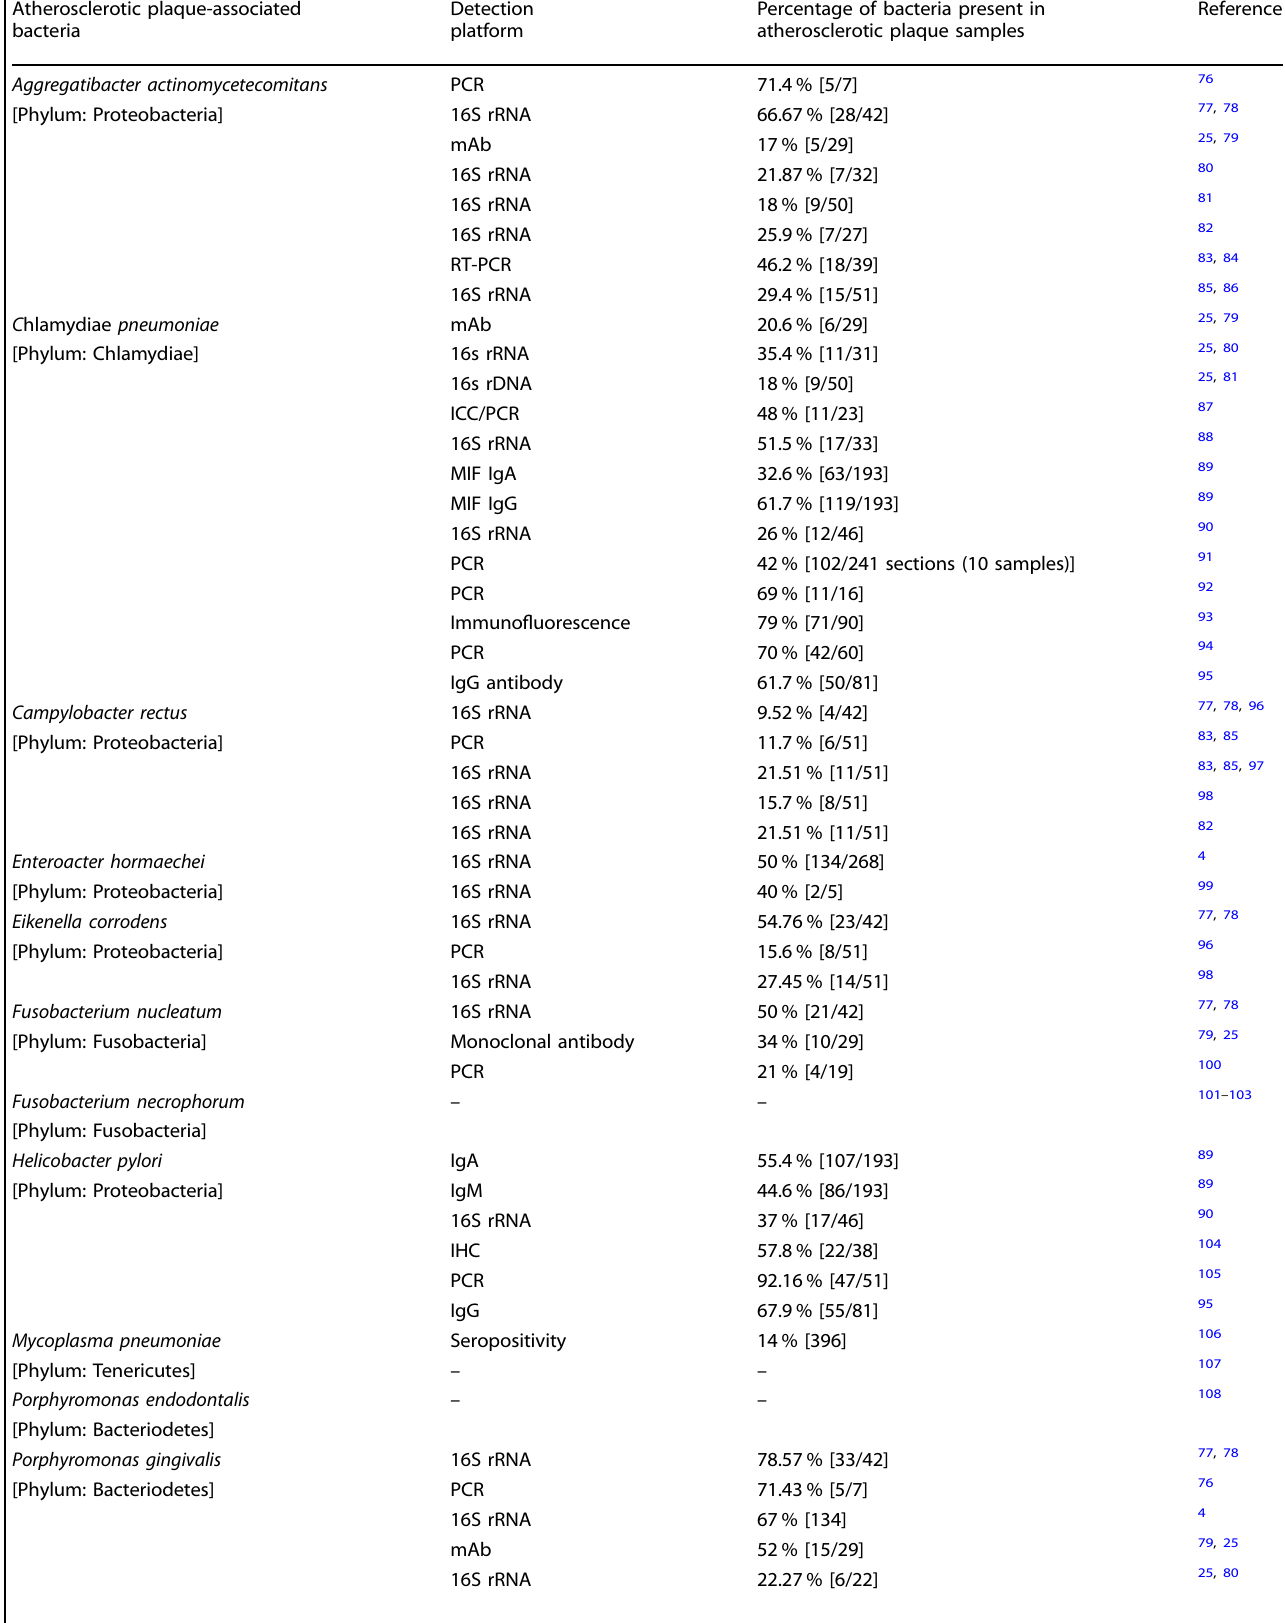
Table 1. Techniques used for identi fi cation of the 23 atherosclerotic plaque-associated bacteria Atherosclerotic plaque-associated